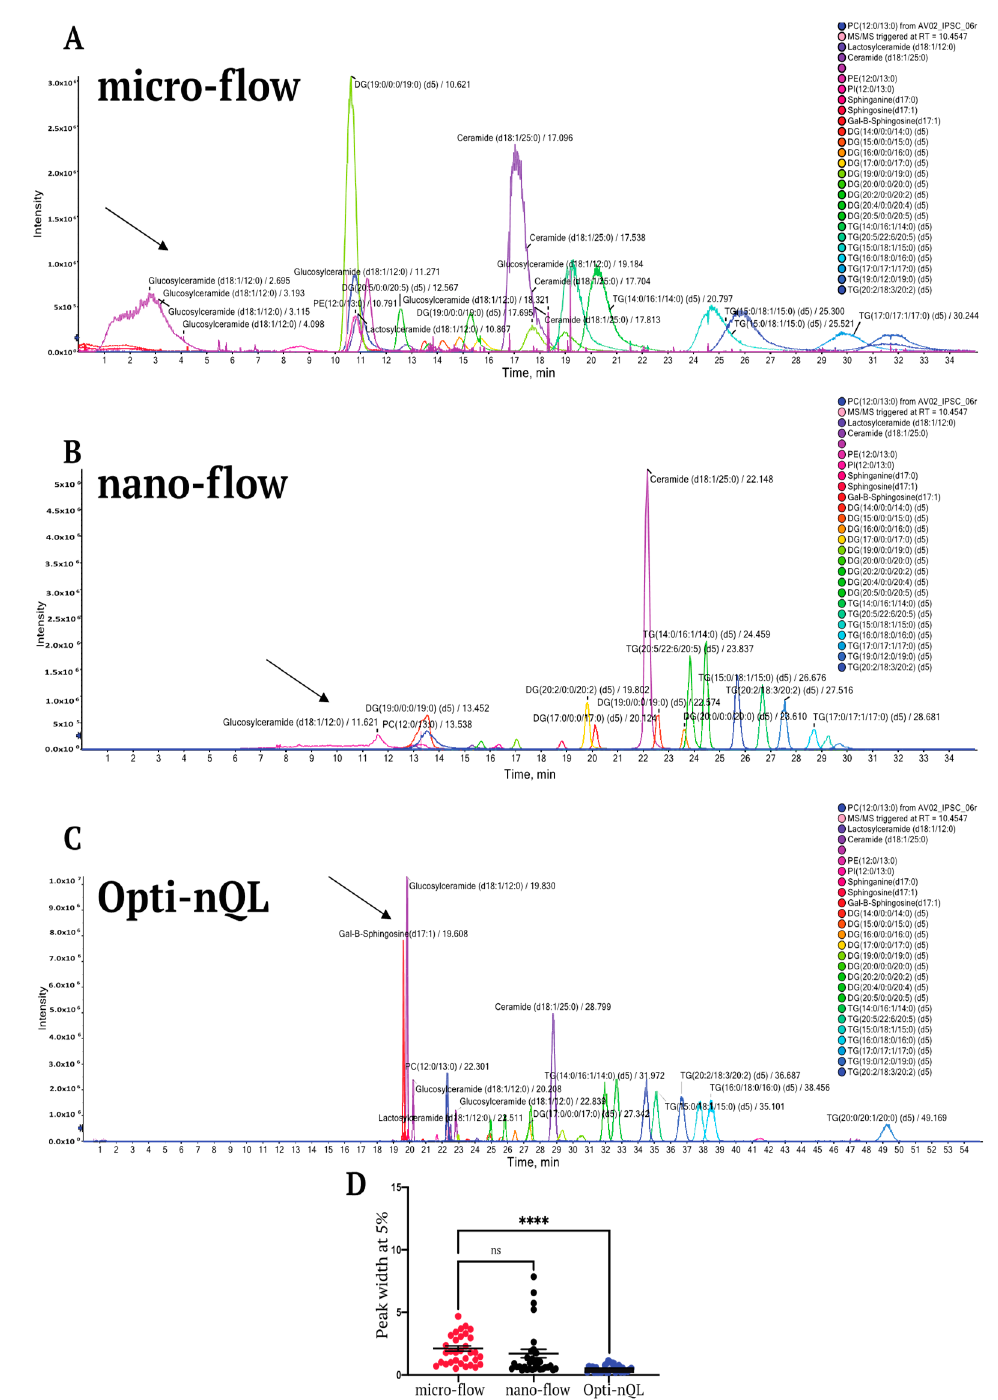
Figure 1. LC chromatographic profiles of the standards mixture. ( A ) Extracted ion chromatogram (EIC) of internal standards (IS) analyzed with micro-flow workflow. ( B ) EIC of IS analyzed in nano-flow workflow. ( C ) EIC of IS analyzed in optimized nano workflow (Opti-nQL). ( D ) Peak width at 5% of the peak height for all IS analyzed in microflow, nanoflow and Opti-nQL. t -test **** p -value < 0.0001. Notably, IS concentration injected in microflow is 1/12 of the amount (pmol) listed in Table 1 while for nanoflow it is